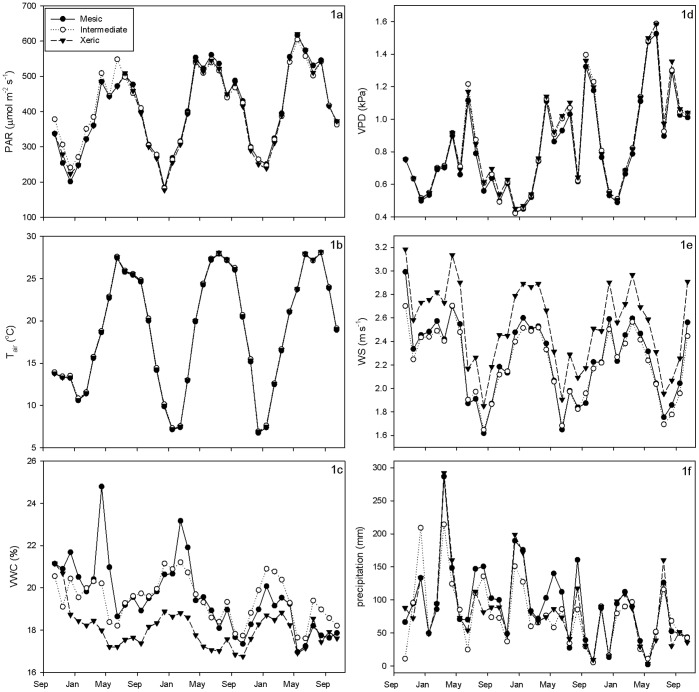
Environmental variables over the study period.Environmental variables measured at xeric (closed triangles, dashed lines), intermediate (open circles, dotted lines) and mesic (closed circles, solid lines) sites at the Jones Center from October 2008 to October 2011. Monthly means were calculated for: (a) photosynthetically active radiation (PAR), (b) air temperature (Tair), (c) volumetric water content of the soil (VWC), (d) vapor pressure deficit (VPD), and (e) windspeed. Monthly sums were calculated for (f) precipitation.